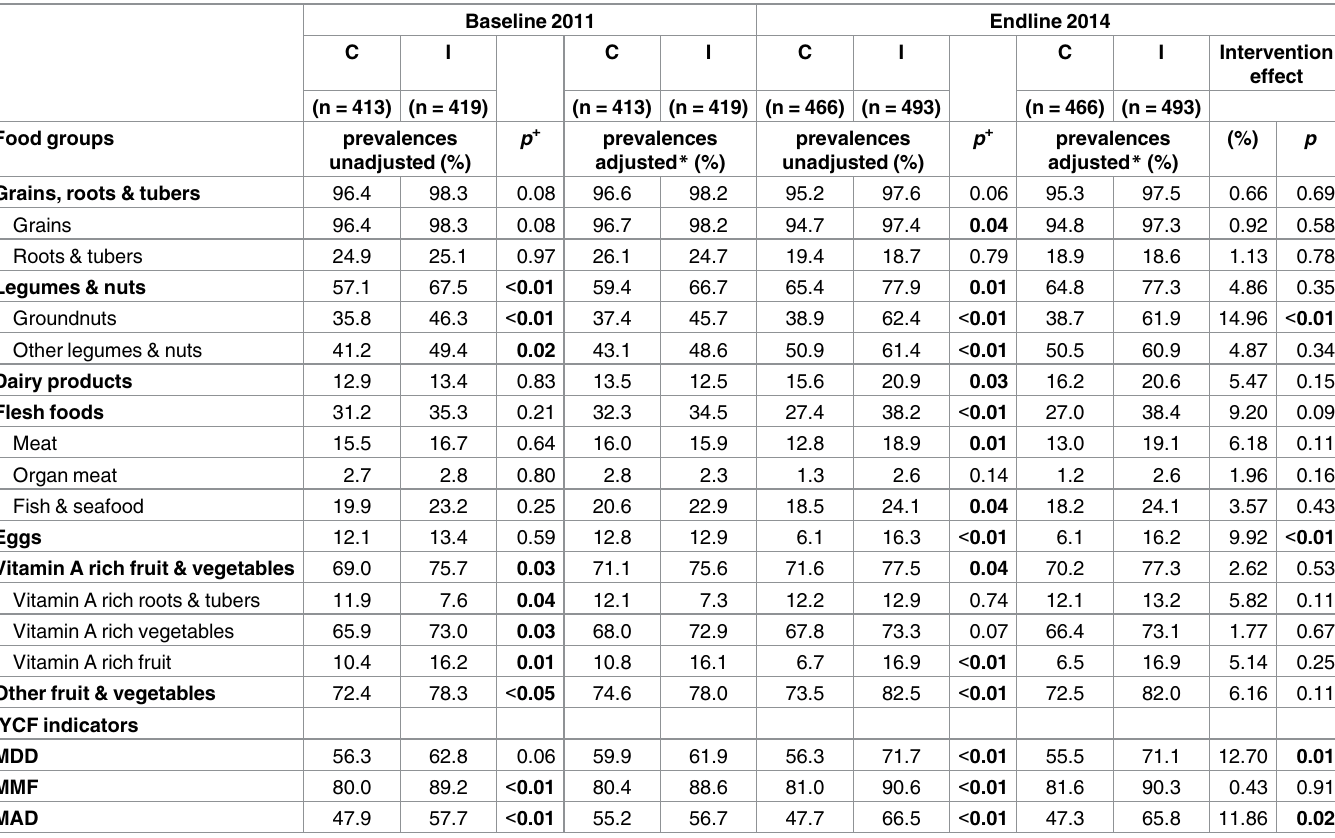
Table 4. Prevalence of food consumption and IYCF indicators at baseline and